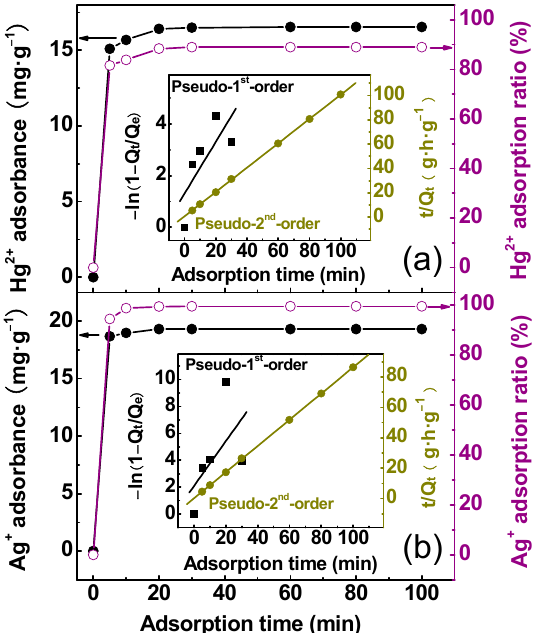
Figure 7. Adsorption kinetics of ( a ) Hg 2+ and ( b ) Ag + ions onto PTT nanoparticles at 25 °C in 50 mL of Hg(NO 3 ) 2 and AgNO 3 solution at the same initial Hg 2+ and Ag + concentration of 20 mg·L − 1 with 50 mg of adsorbent. Inset: kinetic model plots of the adsorption of Hg 2+ and Ag + onto the nanoparticles.